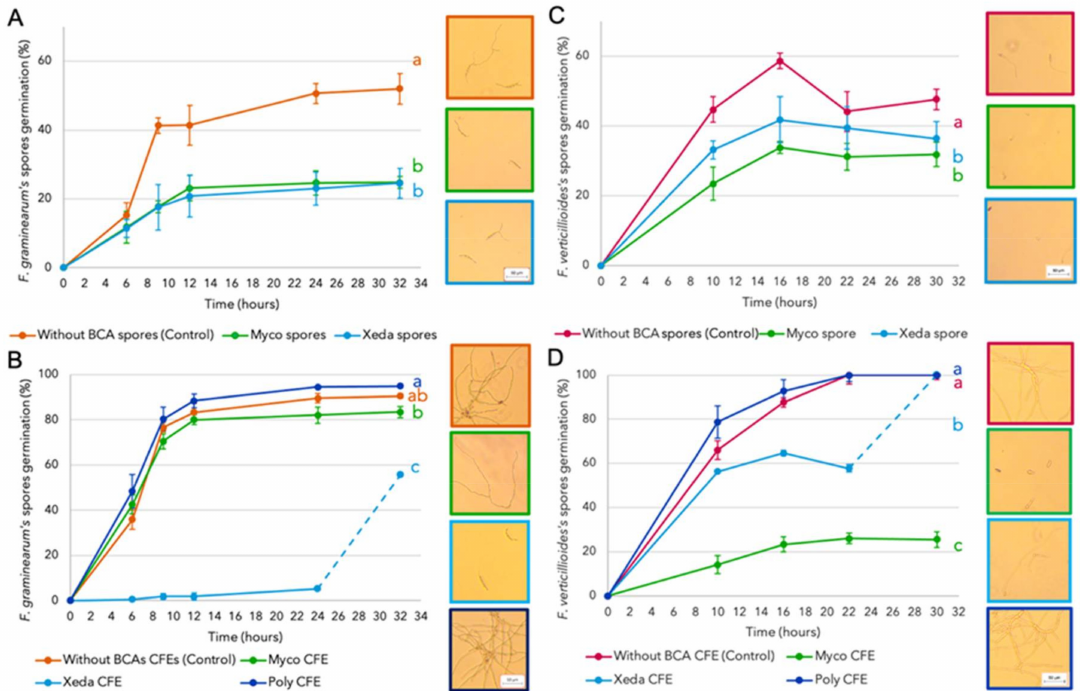
Figure 3. Effect of BCAs on germination of pathogenic spores. F. graminearum spores: ( A ) in contact with BCA spores and ( B ) in contact with BCA cell-free-extracts; on germination of F. verticillioides spores: ( C ) in contact with BCA spores and ( D ) in contact with BCA cell-free-extracts. Optical microscope images were taken after 24 h of contact between pathogen spores and BCA spores or CFEs at 25 ◦ C. Part of the curve in the dotted line indicates an increase of pathogen spore’s germination percentage but with reduced length germ tubes. CFE: cell-free-extract; Myco: Mycostop ® , Xeda: Xedavir ® , Poly: Polyversum ® . ANOVA test independent for each competition modality on area under the growth curves (AUGCs), p -value <